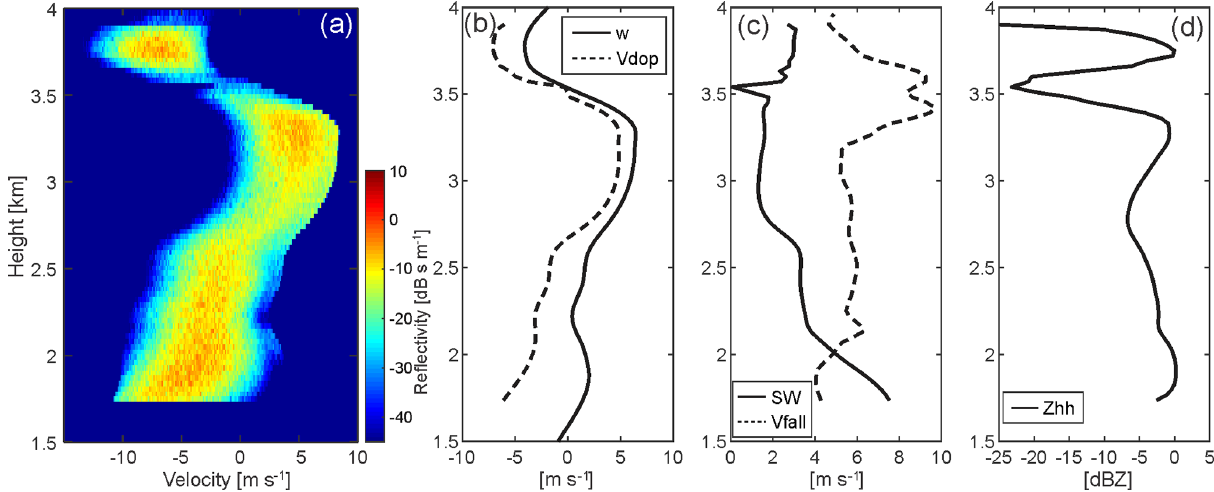
Figure 2. CR-SIM examples of radar observables for a shallow convection LASSO case from a WRF simulation coupled with the Thompson microphysics scheme. Shown are (a) simulated radar Doppler spectra, (b) model vertical velocity ( w , solid line) and simulated mean Doppler velocity ( V dop , dashed line), (c) simulated spectrum width (SW, solid line) and simulated reflectivity-weighted velocity ( V fall , dashed line), and (d) simulated total reflectivity ( Z hh ) at S band (3GHz). In (a) and (b) , a positive sign indicates upward motion, and in (c) a positive sign indicates downward motion (fall speed).